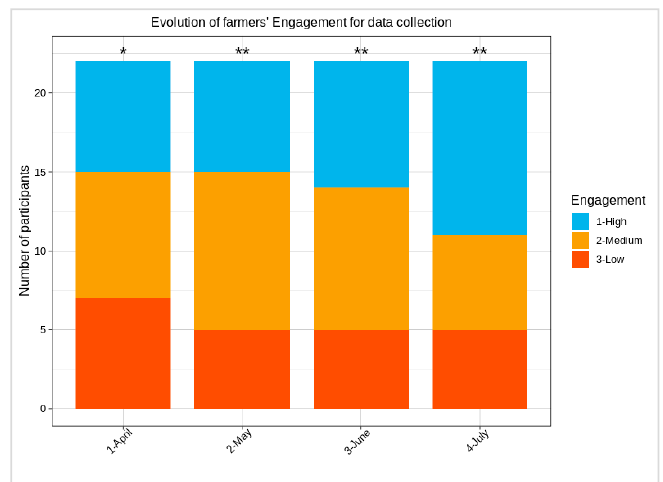
Figure 6. Evolution of participants’ engagement based on their frequency of data collection and interaction via the digital and rain monitoring tools. Asterisks (* and **) indicate the significance of the results for the combined “medium and high engagement” category at, respectively, p < 0.05 and p < 0.01, based on a binomial distribution test.